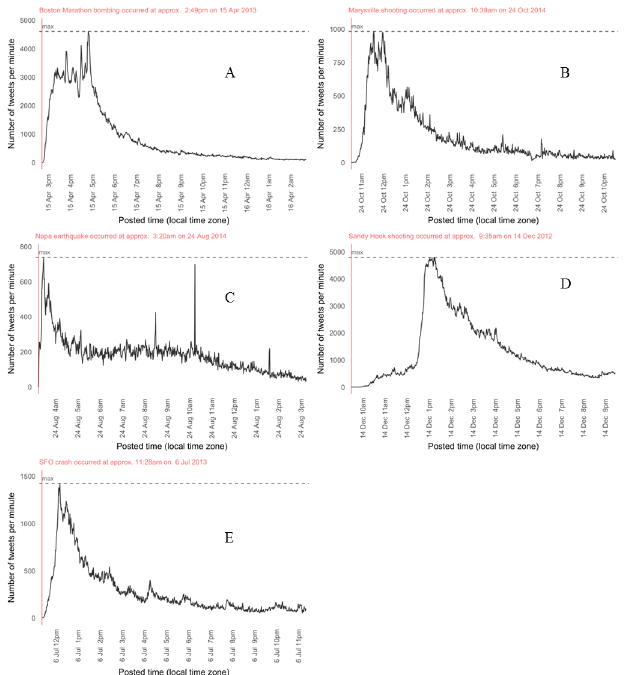
Fig 1. Tweets per minute in the first 12 hours following each event. Panel A: Boston Bombing; Panel B: MaryvilleSchool Shooting; Panel C: Napa Earthquake; D: Sandy Hook Elementary School Shooting;Panel E: San Francisco Air Plane Crash.